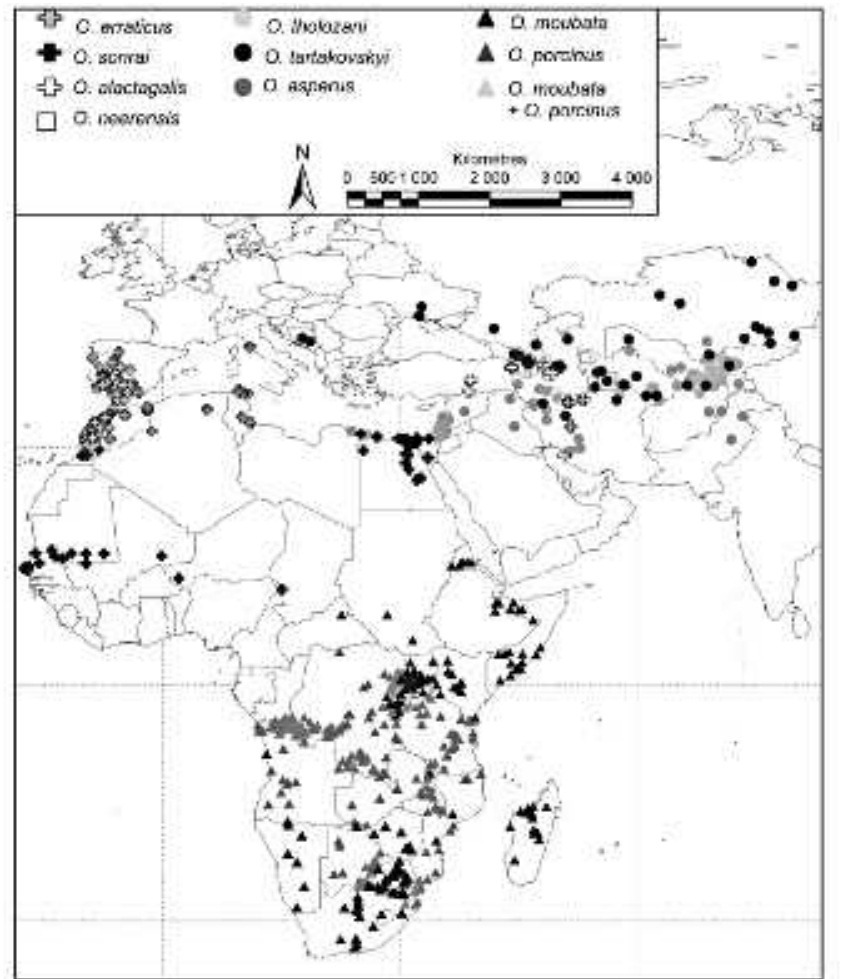
Fig. 3. – Geographical location of Morel’s presence data for several species of Orni- thodoros ticks transmitting TBRF and/or ASFV in Eurasia and Africa. 1052 records were reported and 865 were geographi- cally localized using the US Army Gazeeter (http://tomcat-dmaweb1.jrc.it/fuzzyg/